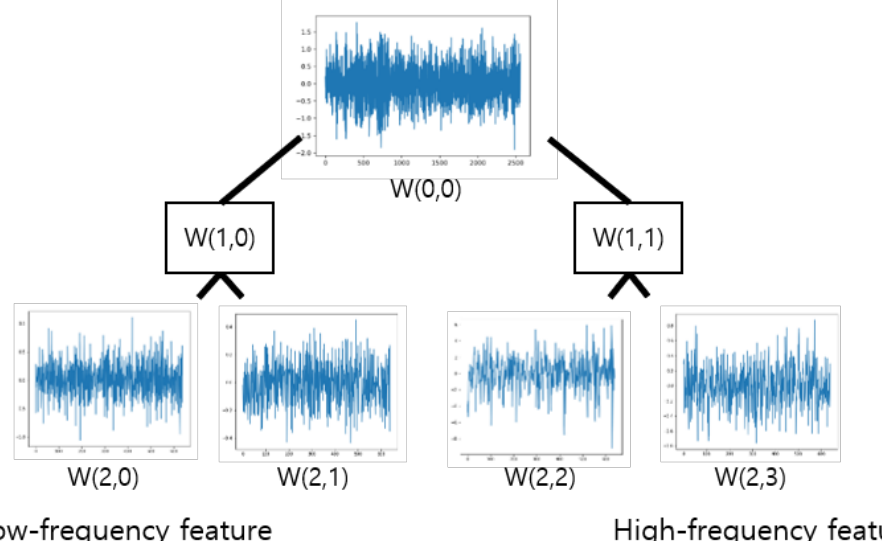
Figure 4. Decomposition result of WPD up to Level 2.